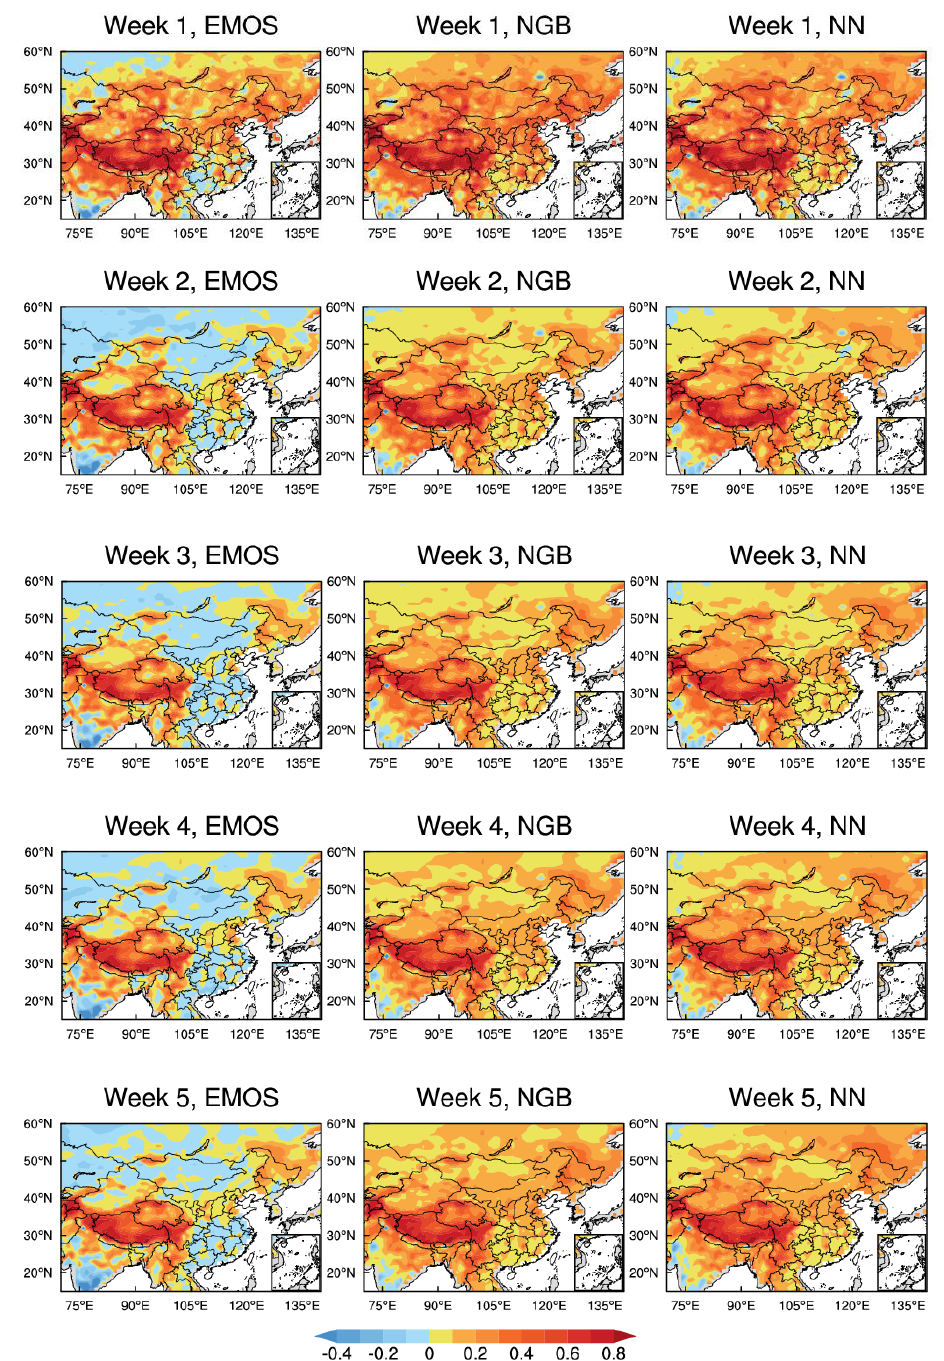
Figure 7. Continuous ranked probability skill score distribution of the 2-m maximum air temperature probabilistic forecasts for all land grid points over East Asia verified against the raw ensemble using different post-processing methods at different lead times. EMOS, ensemble model output statistics; NGB, natural gradient boosting; NN, neural networks.